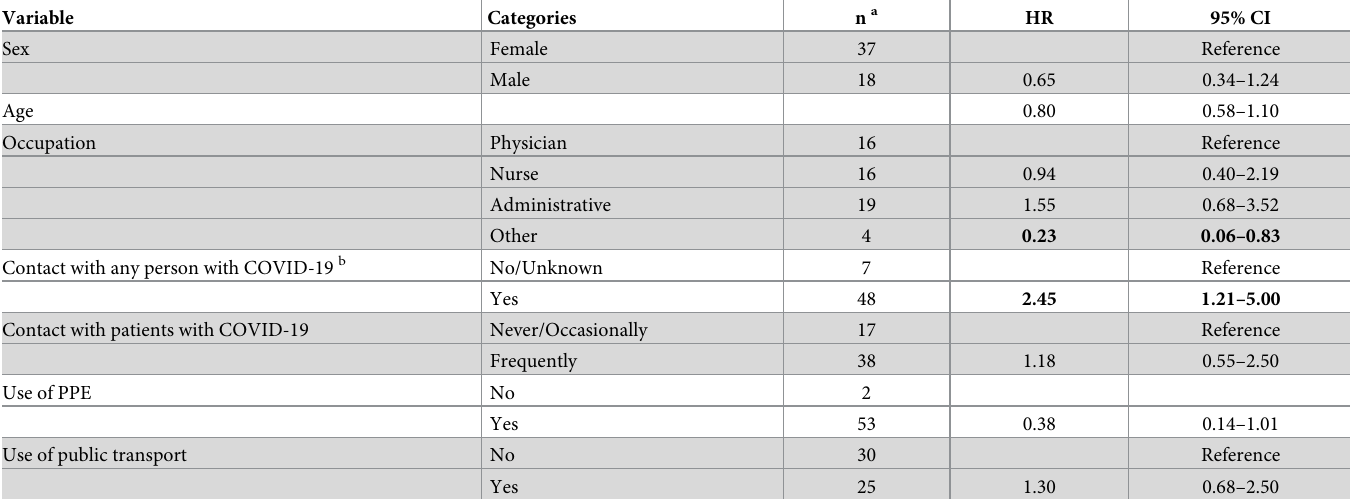
Table 3. Cox model on risks associated with being an incident case in healthcare workers of the two largest COVID-19 referral hospitals in Mexico City, October 2020-June